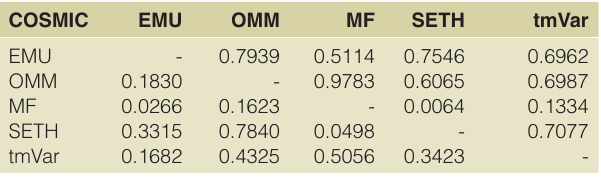
Table 12. Overlap of mutations extracted by each tool on the COSMIC database from all article data sources. The tools are Extractor of Mutations (EMU), OpenMutationMiner (OMM), MutationFinder (MF), tmVar and SNP Extraction Tool for Human Variations (SETH).